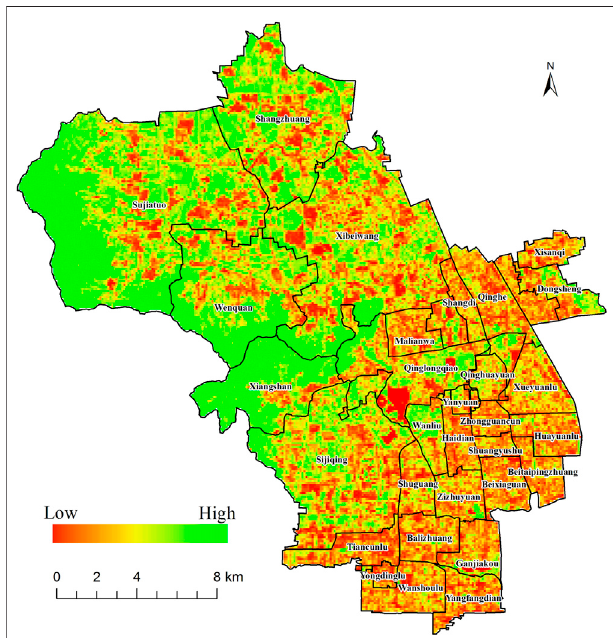
FIGURE 6 | Map of ecological quality (EQ1) using six-indicator-based factor analysis in Haidian district.